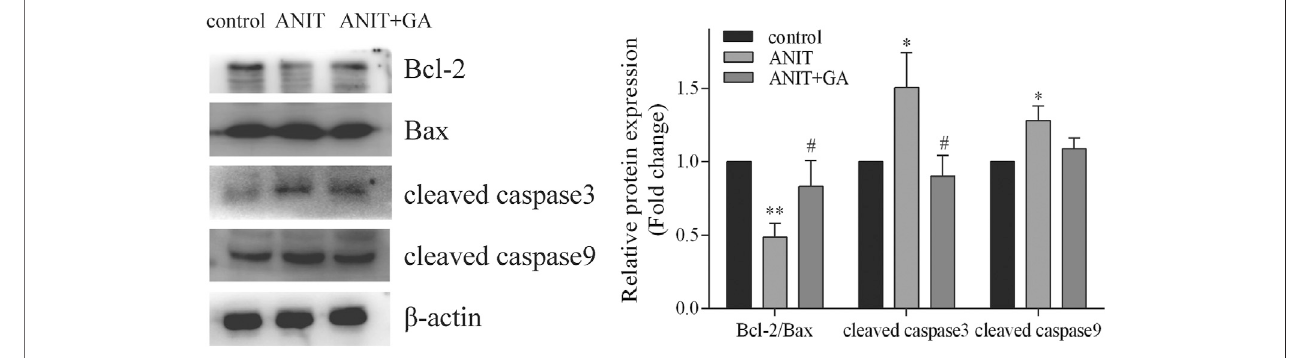
FIGURE 7 | Effects of GA on the expression of the apoptotic signaling pathway ( n (cid:1) 6).